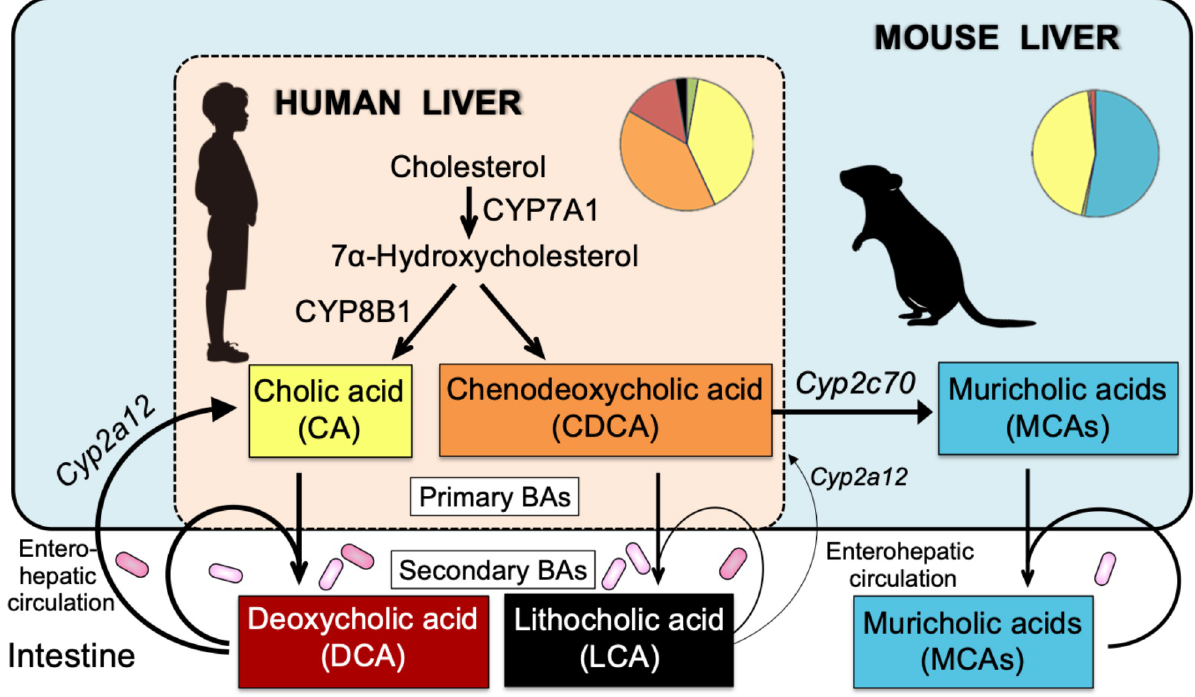
Fig 1. Comparison of bile acid (BA) metabolism between human and mouse. CA and CDCA are end products in the human liver, but the mouse liver further metabolizes CDCA to MCAs by CYP2C70. In addition, the mouse liver can convert secondary BAs, DCA and LCA, into CA and CDCA by CYP2A12. Because of the low intestinal re-absorption rate (human and mouse) and small CDCA pool (wild-type mouse), the enterohepatic circulation of LCA is usually less (thin arrows) than those of other BAs (thick arrows). Knockout of the Cyp2a12 and Cyp2c70 genes results in mice with a human-like hydrophobic BA composition. Cyp2a12 and Cyp2c70 are genes responsible for hepatic BA 7 α -hydroxylation and CDCA 6 β - hydroxylation,